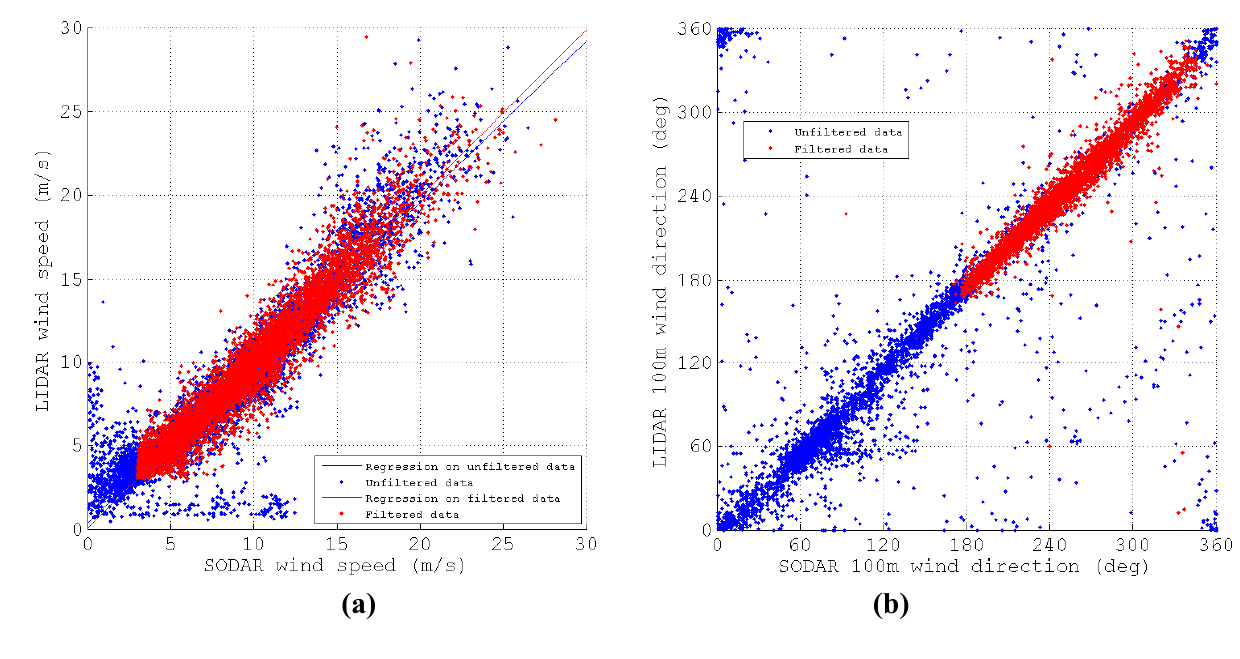
Figure 9. Comparison of 100 m (a) wind speed; and (b) wind direction, from LIDAR and SODAR. (February–May; 10 min